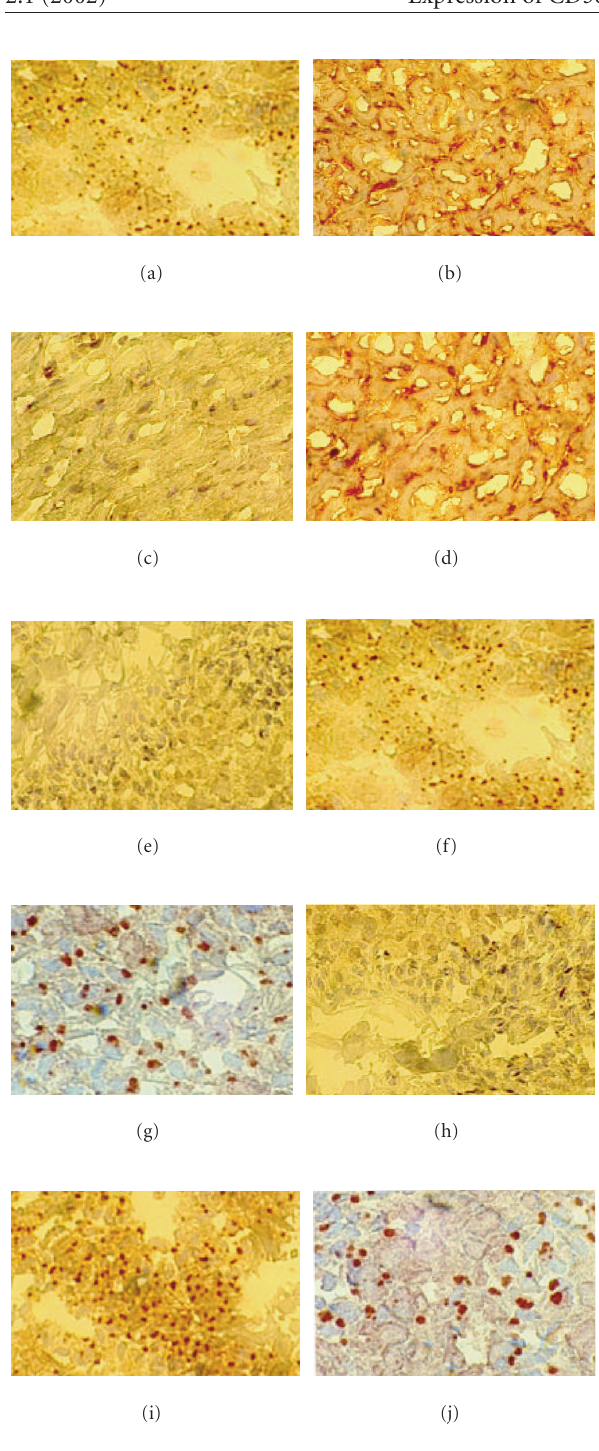
Figure 6. Immunohistochemistry analysis of CD36 in the heart and testis: CD36 immuno-staining of murine heart and testis at 16weeks of chow diet. Heart ((b) and (d)), and testis ((f), (g), (i), and (j)) were immuno-stained through the use of a guinea pig anti-murine CD36 polyclonal antibody. Heart((a)and(c))andtestis((e)and(h))negativecontrolswereperformed using a non-immune guinea pig serum. (a), (b), (e), (f), (g) show wild-type (C57BL/6) hearts or testis. Panels (c), (d), (h), (i), (j) show apoE − / − hearts or testis. Magnifications are X100 for (a), (b), (c), (e), (f), (h), (i), and X250 for (g),